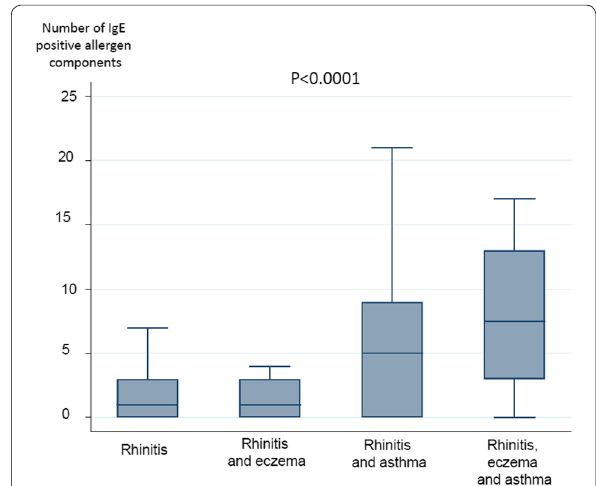
Fig. 4 Association between the number of IgE-positive allergen components and having rhinitis with asthma/eczema. *median and interquartile range Table 4 Variables associated with having asthma with eczema and/or asthma compared with only having rhinitis